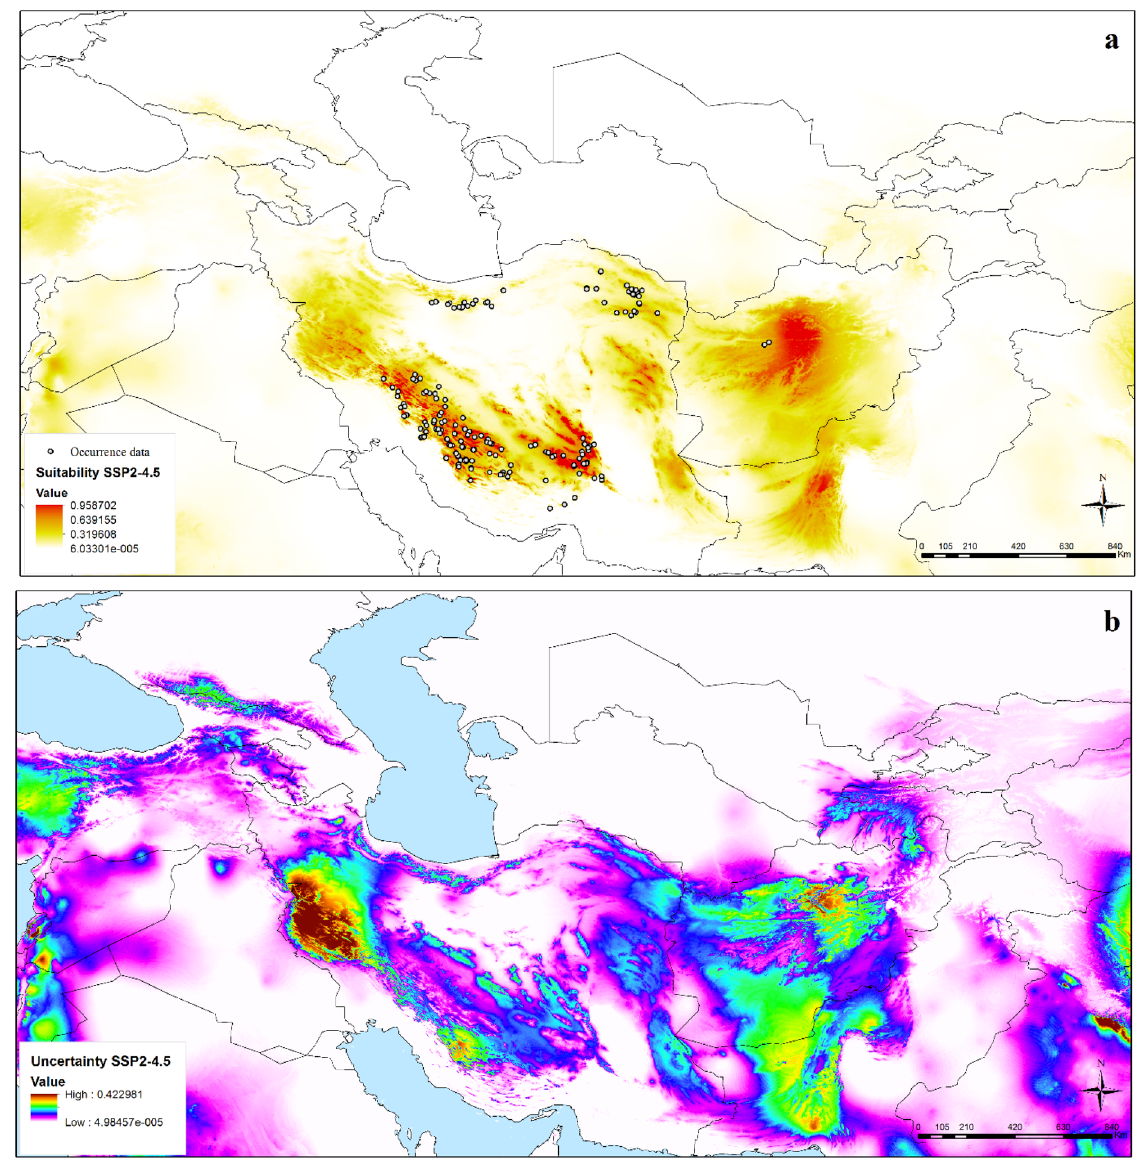
Figure 4. Potential future distribution of Nepeta glomerulosa under Shared Socioeconomic Pathways (SSP2-4.5) across the southwestern and central Asia: ( a ) median prediction, ( b ) uncertainty map (ArcGIS version 10.3.1; http:// www. esri.